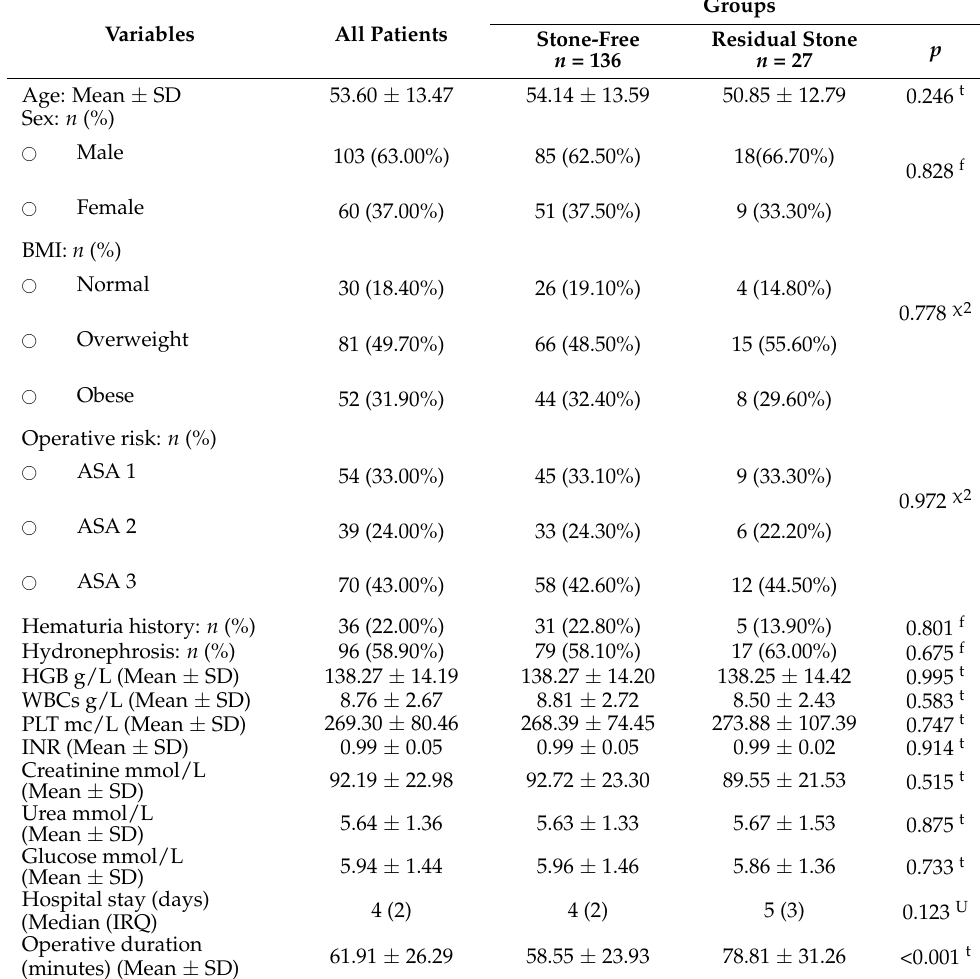
Table 1. Demographic and clinical